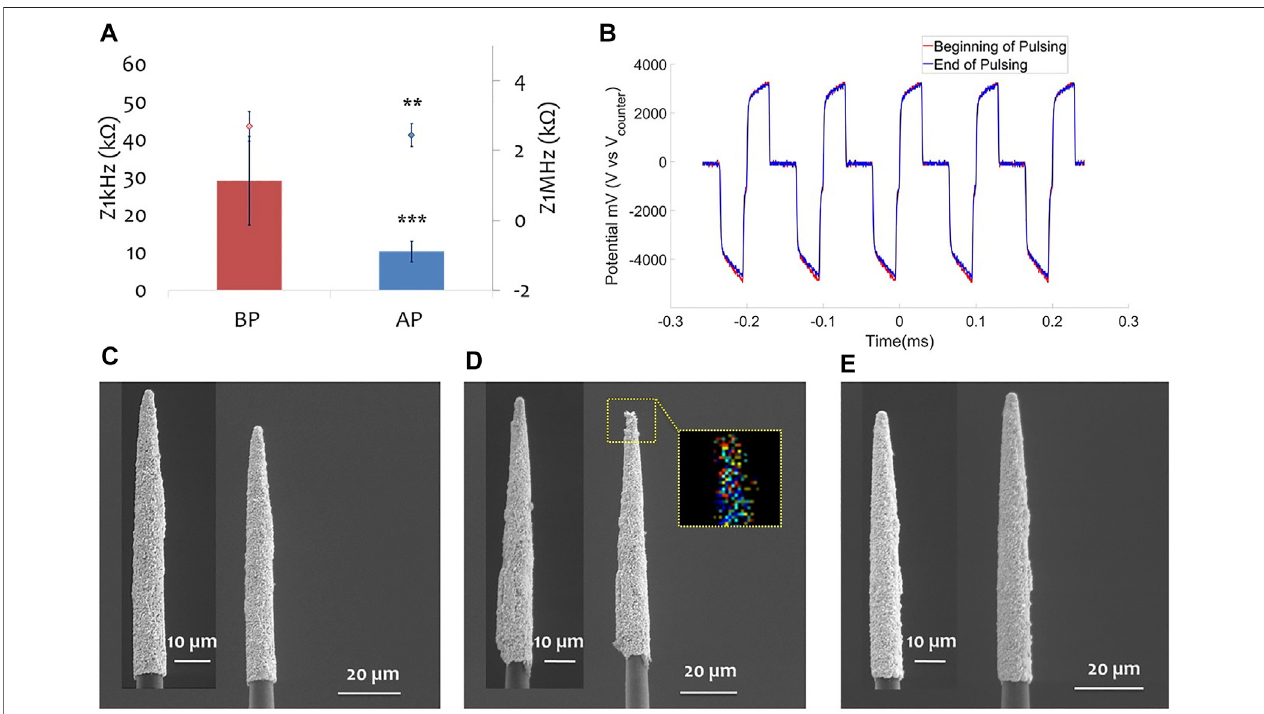
FIGURE 6 | 10 kHz Electric pulse test. (A) EIS of one PtIr-CF before (red solid line) and after (blue solid line) the pulsing test. (B) Voltage transient for one PtIr-CF at thebeginning(red)andattheend(blue)ofpulsingtest;abiphasicpulseof30 μ sdurationandamplitudeof710 μ A(1 mC/cm 2 )wasapplied. (C – E) SEMofthreePtIr-CFs before (as inset) and after 3 h of electric pulsing, in (D) one EDS is reported as inset with highlighted (yellow box) on the tip the presence of Na (red) and Cl (yellow) molecules, in blue and cyan the Ir and Pt molecules are shown as well.